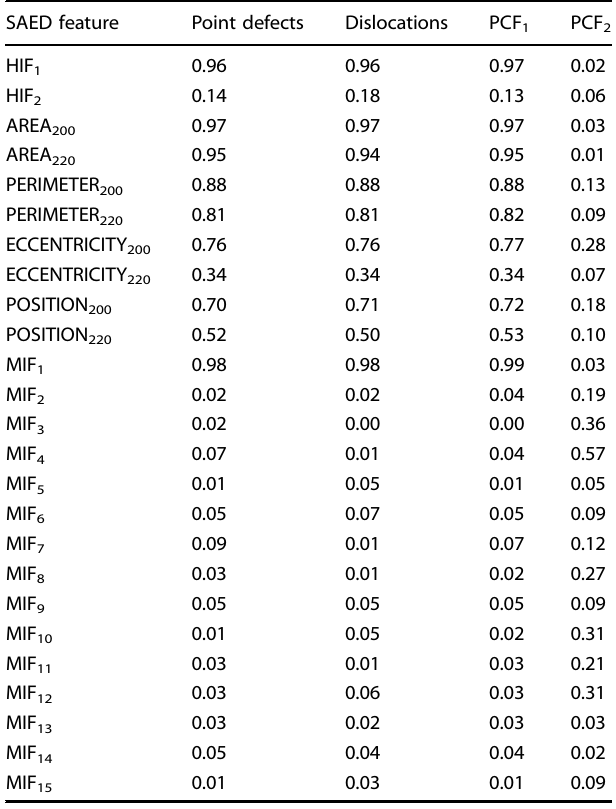
Table 1. Pearson linear-correlation coef fi cients of the (top 10 rows) human-identi fi ed features (HIFs) and (bottom 15 rows) machine- identi fi ed features (MIFs) with the desired defect statistics (i.e., point- defect density, dislocation density, and the fi rst two principal components of the pair-correlation function (PCF) of the point-defect distribution).